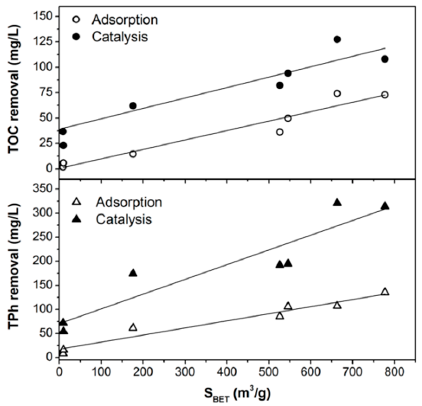
Figure 12. Influence of the specific surface area ( S BET ) on the TPh and TOC removals by adsorption and catalysis (in mg/L).